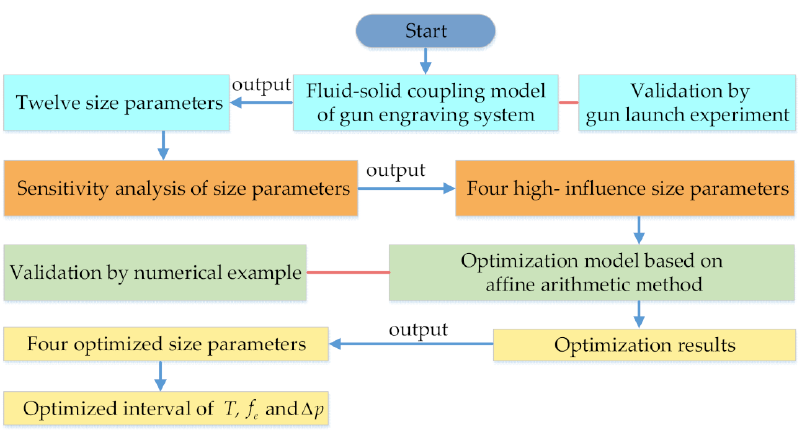
Figure 1. Flow chart of the present work in this